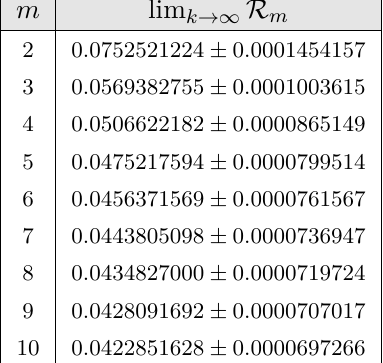
Figure 12. Variation of Rényi entropies for the state | 4 1 # T 2 , 2 i with k